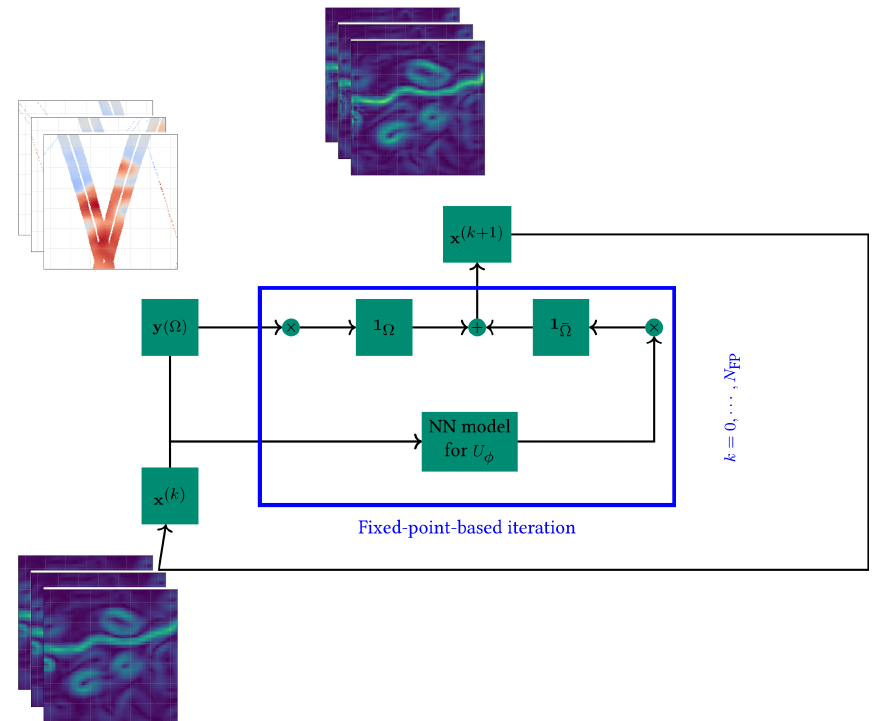
Figure A1. Sketch of the iterative fixed-point algorithm. The upper-left stack of images corresponds to an example of SSH observations temporal sequence, with missing data used as input. The upper-right stack of images is an example of an intermediate reconstruction of the SSH gradient at iteration i , while the bottom-left stack of images identifies the updated reconstruction fields used as new inputs after each iteration of the